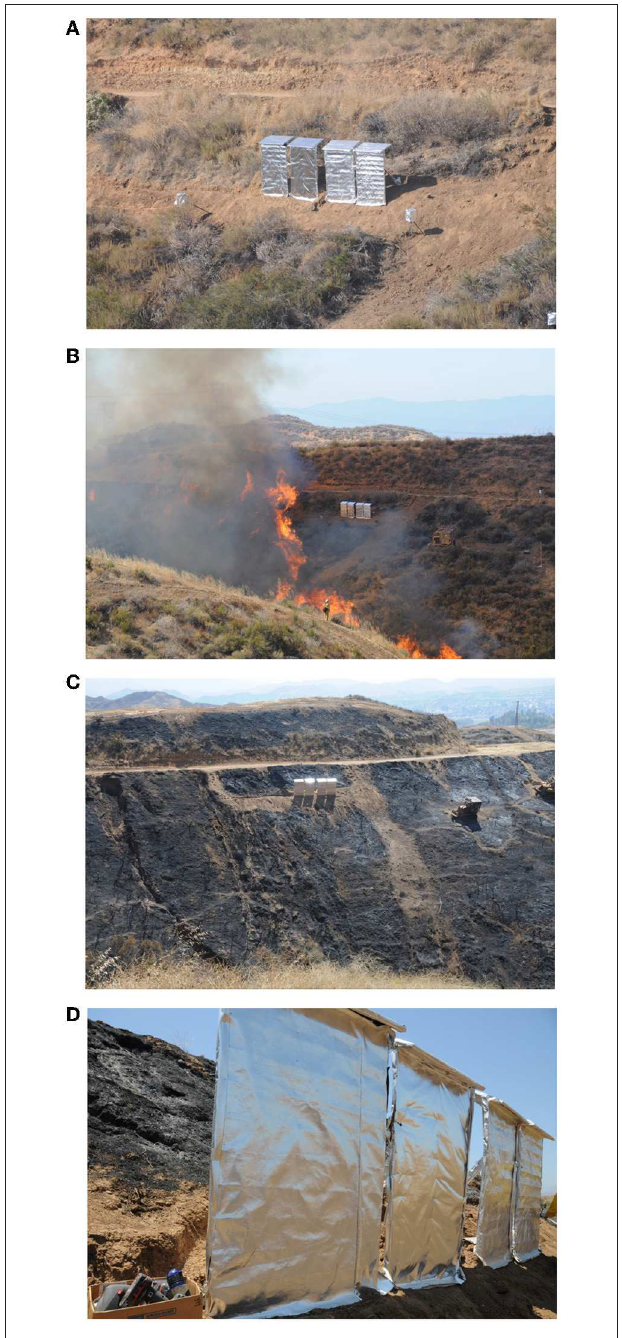
FIGURE 4 | Photographs of Burn #1. (A) Four wall-and-eave wood structures covered with different fire blankets (see Table 4 ) standing on the slope and two protected camera box stands on both sides, (B) the fire front is climbing up the slope and approaching the structures, and (C,D) the undamaged wood structures with fire blankets after the prescribed